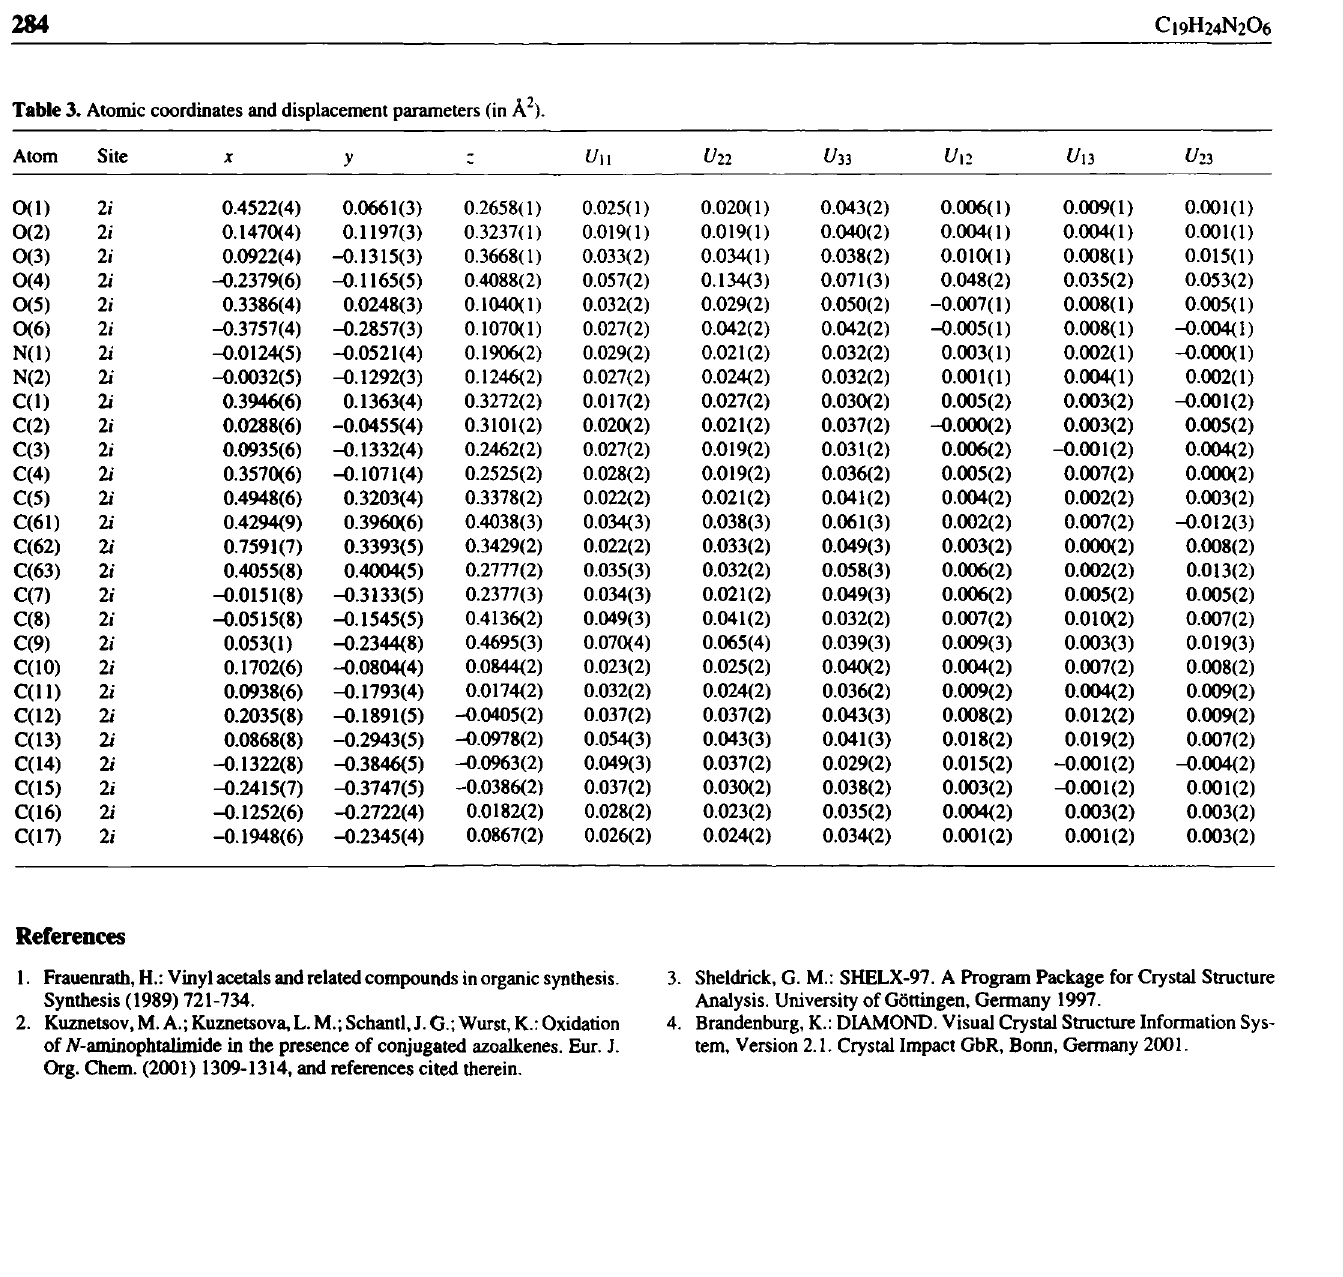
Table 3. Atomic coordinates and displacement parameters (in À 2